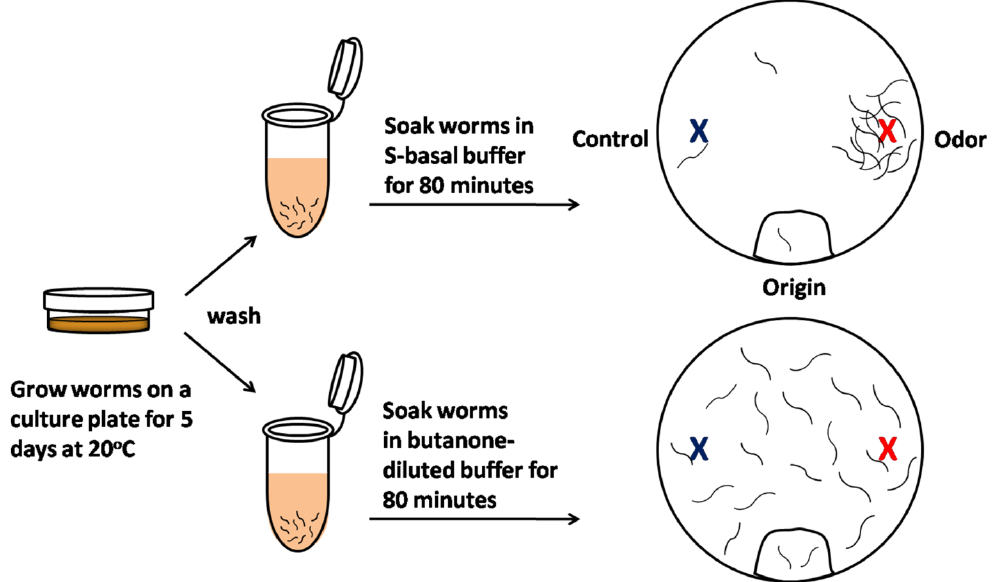
Figure 2. Scheme of olfactory learning assay in C. elegans . In the olfactory learning assay, olfactory behavior is quantified by the measurement of the chemotaxis index (CI). Five-day-old animals were cleaned to remove bacteria, half were pre-exposed to S-basal buffer alone ( top ), and half were pre-exposed to S-basal-diluted odor buffer, containing an odorant such as butanone ( bottom ). After the worms were incubated for 80 min, the animals were placed at the ‘origin’ of an assay plate containing an ethanol-diluted butanone spot (red) and a control ethanol spot (blue). The worms were allowed to roam around the dish for 120 min at 20 °C. The CI is the number of worms near the attractive odor subtracted from the number of worms near the control ethanol spot, divided by the total worms on the assay plate. These same worms can subsequently be screened to determine whether long-term olfactory learning occurs.